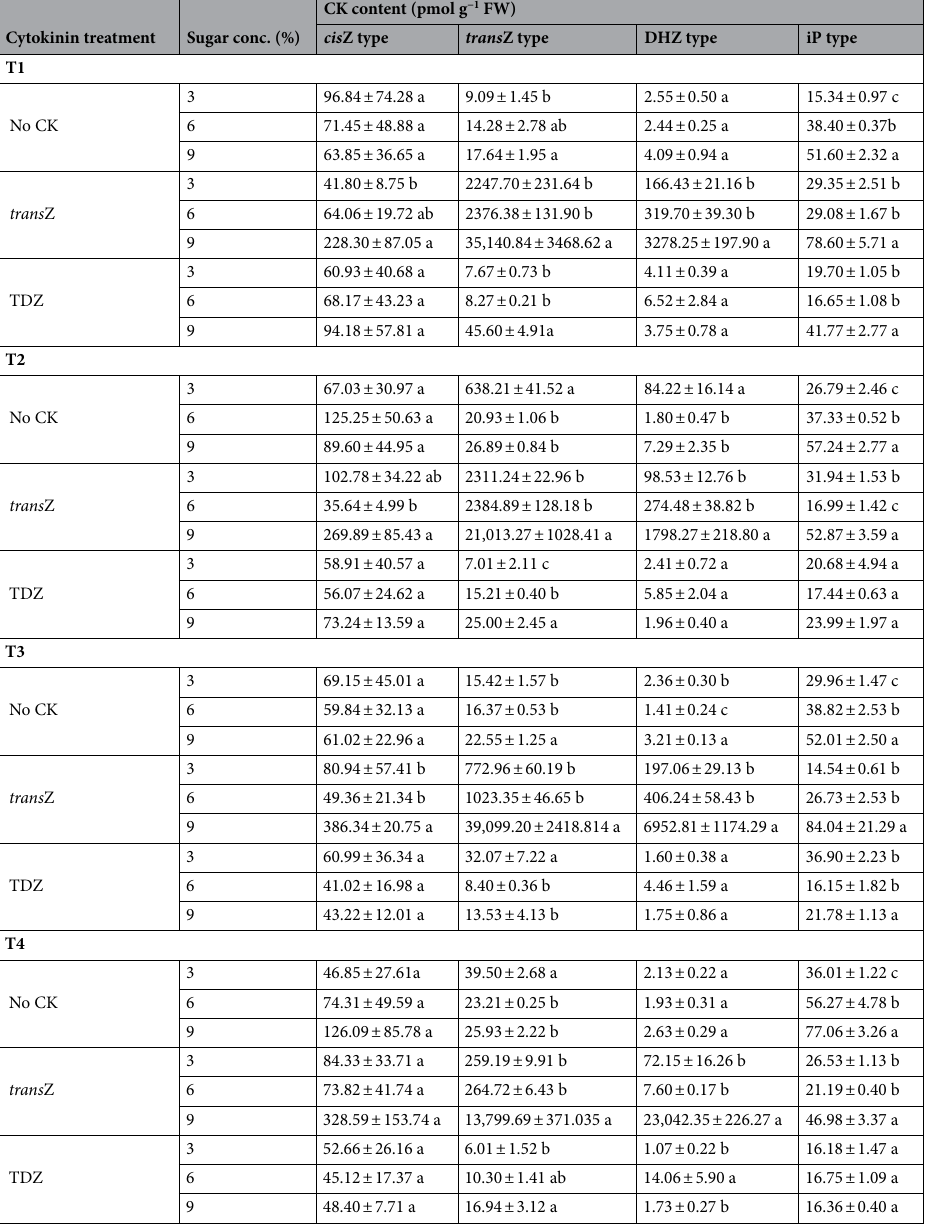
Table 1. Cytokinin contents (in pmol g −1 FW) in four developmental stages (T1-T4) during kohlrabi (cv. Vienna Purple) growth and de novo shoot organogenesis on media containing different cytokinins and increasing concentration of sucrose. Endogenous cytokinins are divided into 4 groups based on their side chain structure: cis Z-, trans Z-, DHZ- and iP-types. Results are presented as mean ± SE (n = 3). Different letters indicate statistically significant difference between means within a column for each developmental stage